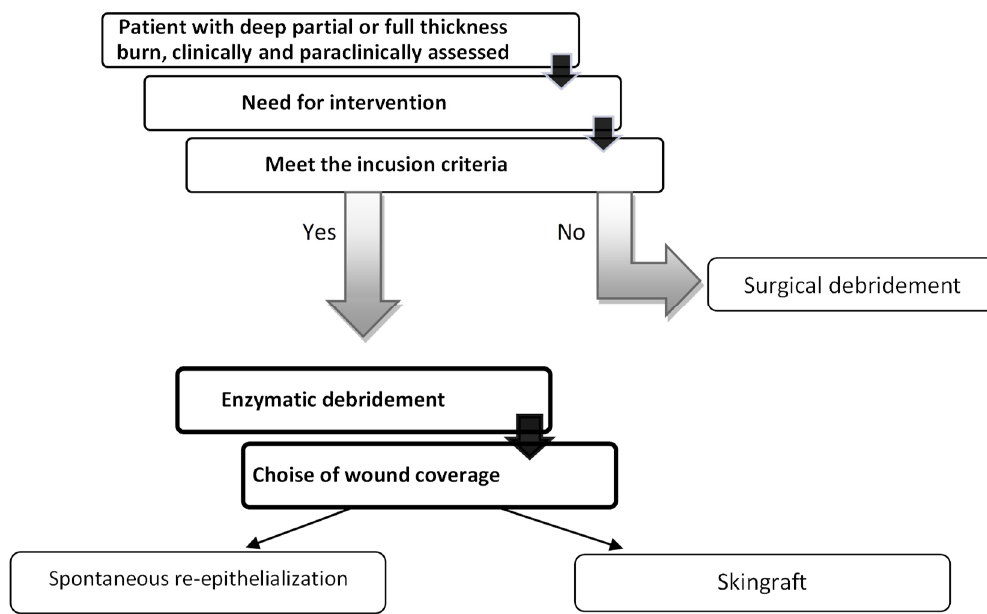
Figure 1. Flow of study progression.